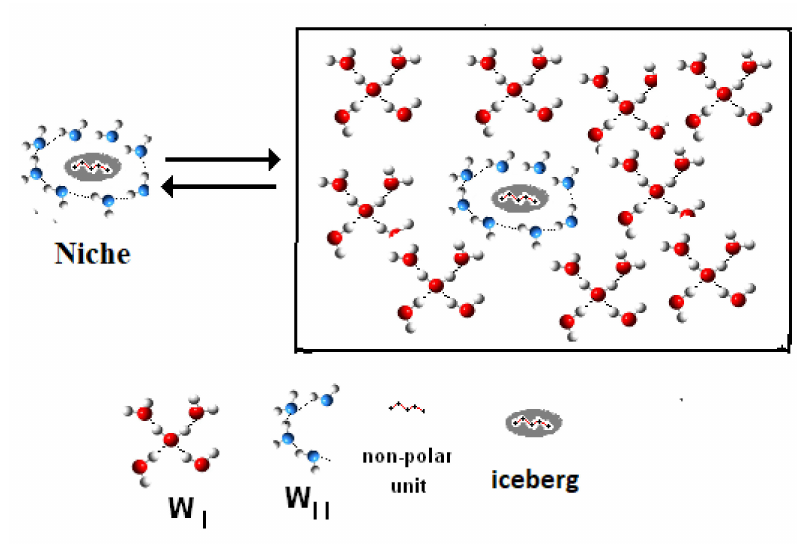
Figure 6. Class A. Reaction of iceberg